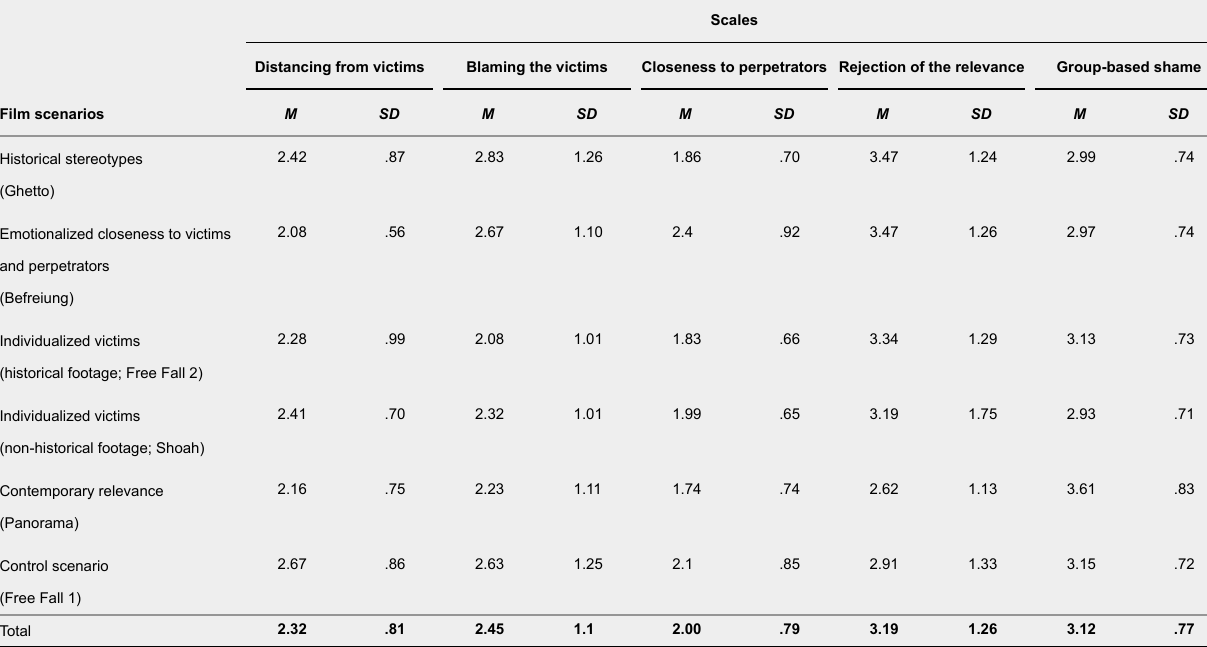
Defense Strategies and Group-Based Shame Between Scenarios: Means and Standard Deviations